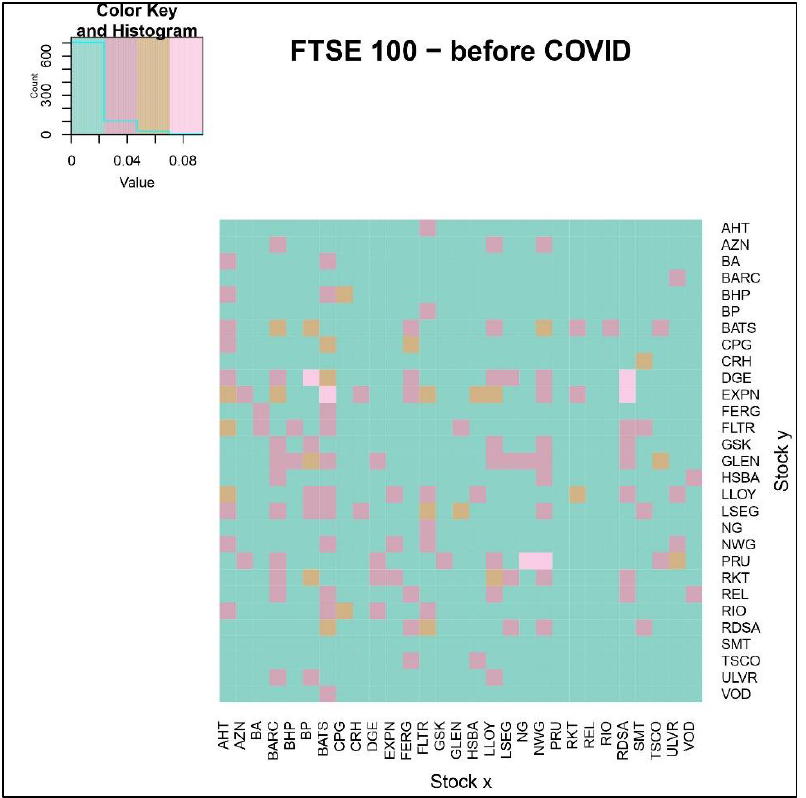
Figure 7. The information flow (effective transfer entropy) from stock y to stock x, for the top companies (by market capitalization) in the FTSE market, before the COVID-19 outbreak